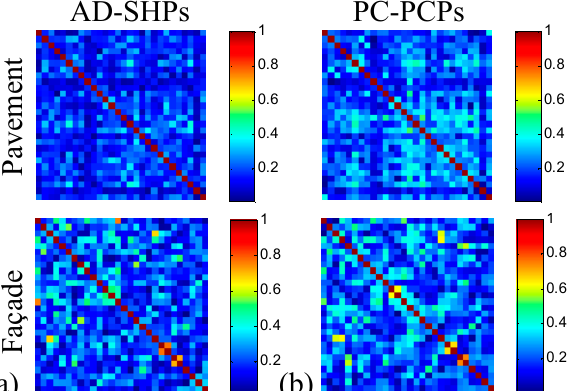
Figure 11. Neighborhood estimated by ( a ) SHPs from AD test, ( b ) PCPs from phase correlation and ( c ) their overlaps of a DS pixel on a pavement surface and building façade, respectively. Red and green dots indicate the reference point and the SHP/PCP neighbors.